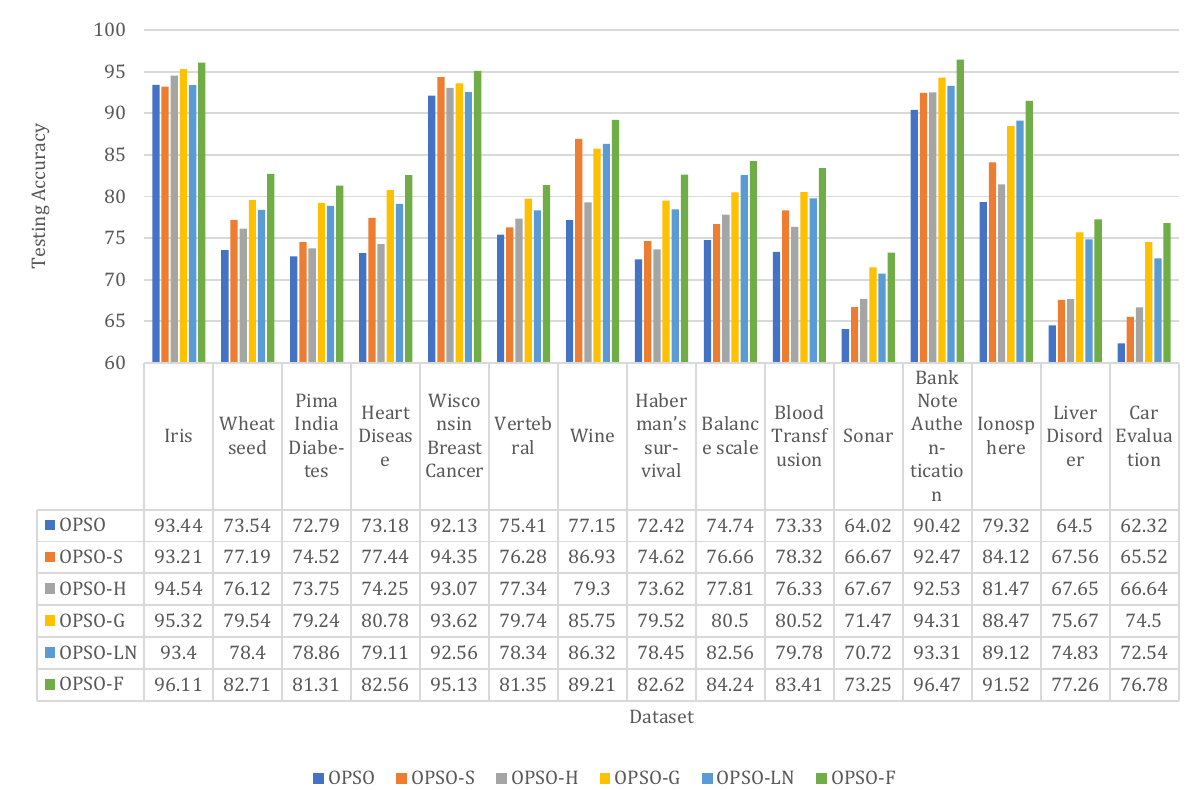
Table 3. One-way ANOVA result test of QRS with Opposition-Based PSO approaches. Figure 11. Testing accuracy result of QRS with opposition-based PSO approaches.